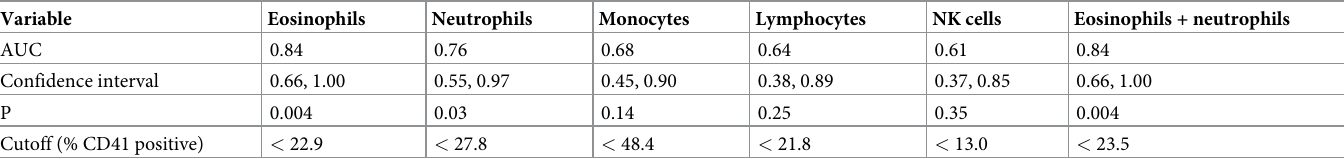
Table 2. ROC analysis for the ability of percentage CD41-positive leukocytes to predict PEC < 6 at V2. Variable